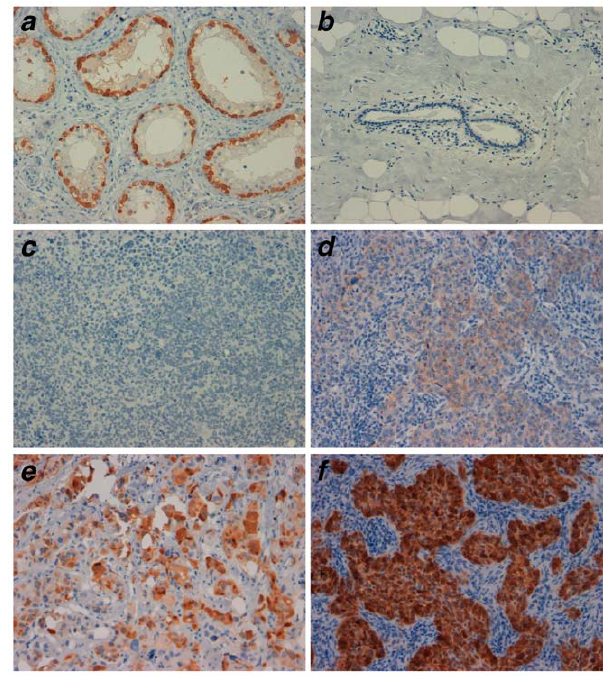
Figure 4. Assessment of ESO expression in BC lines. A . ER ( ESR1 ) and ESO expression in the indicated BC lines was assessed by qPCR. B . MDA-MB-157 cells were transfected with a plasmid encoding the full length ER (pESR1) or were mock transfected and ER and ESO expression was assessed 24, 48 and 72 h post-transfection by qPCR.